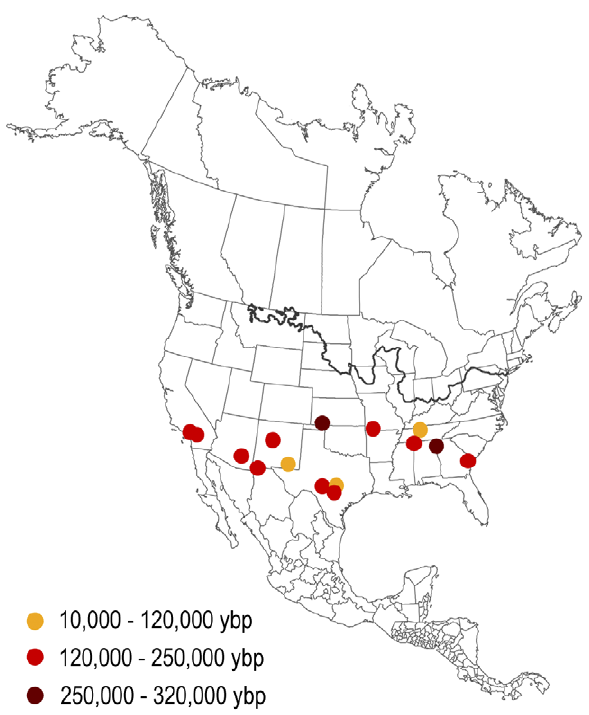
Figure 6. Fossil occurrences of Crotalus in North America for the last 320,000 years. Orange points show occurrence sites whose maximum ages are less than 120 kya, red points show sites with maximum ages between 120–250 kya, and brown points show sites with maximum ages between 250–320 kya. The data were downloaded from the Paleobiology Database (http://pbdb.org) on 22 May 2011, using the group name ‘ Crotalus ’.